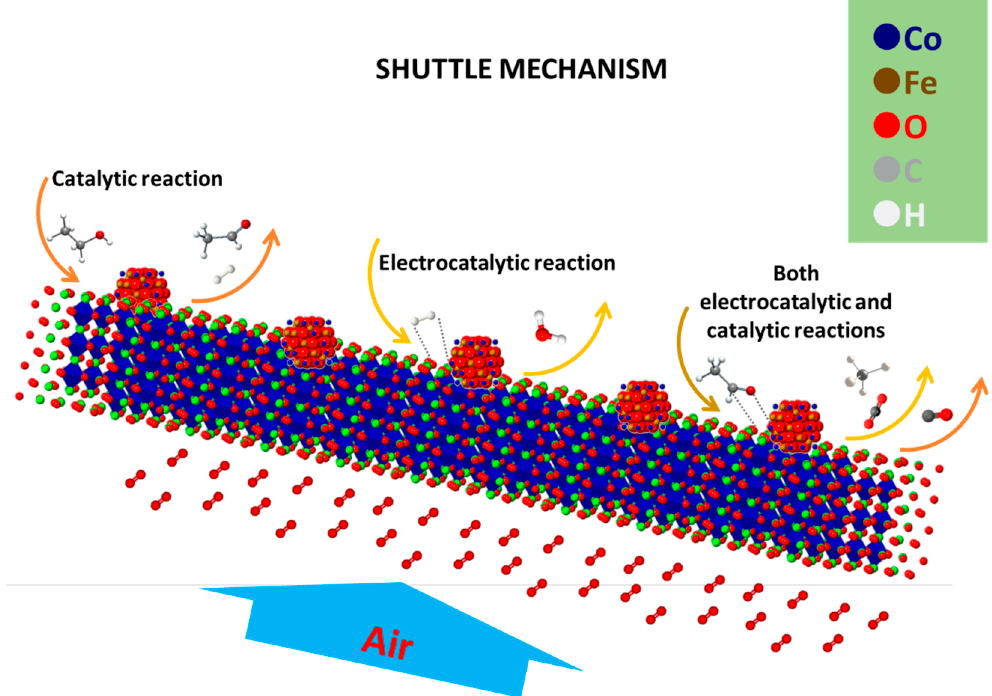
Figure 5. Exemplification of the shuttle mechanism suggested for dry ethanol fed at a modified perovskite-based SOFC cell. The support represents the exsolved perovskite, whereas the fine embedded particles are ascribed to the α -Fe100-y-zCoyNizOx oxide. Air is fed to the cathode, and oxygen ions migrate to the anode through the electrolyte.